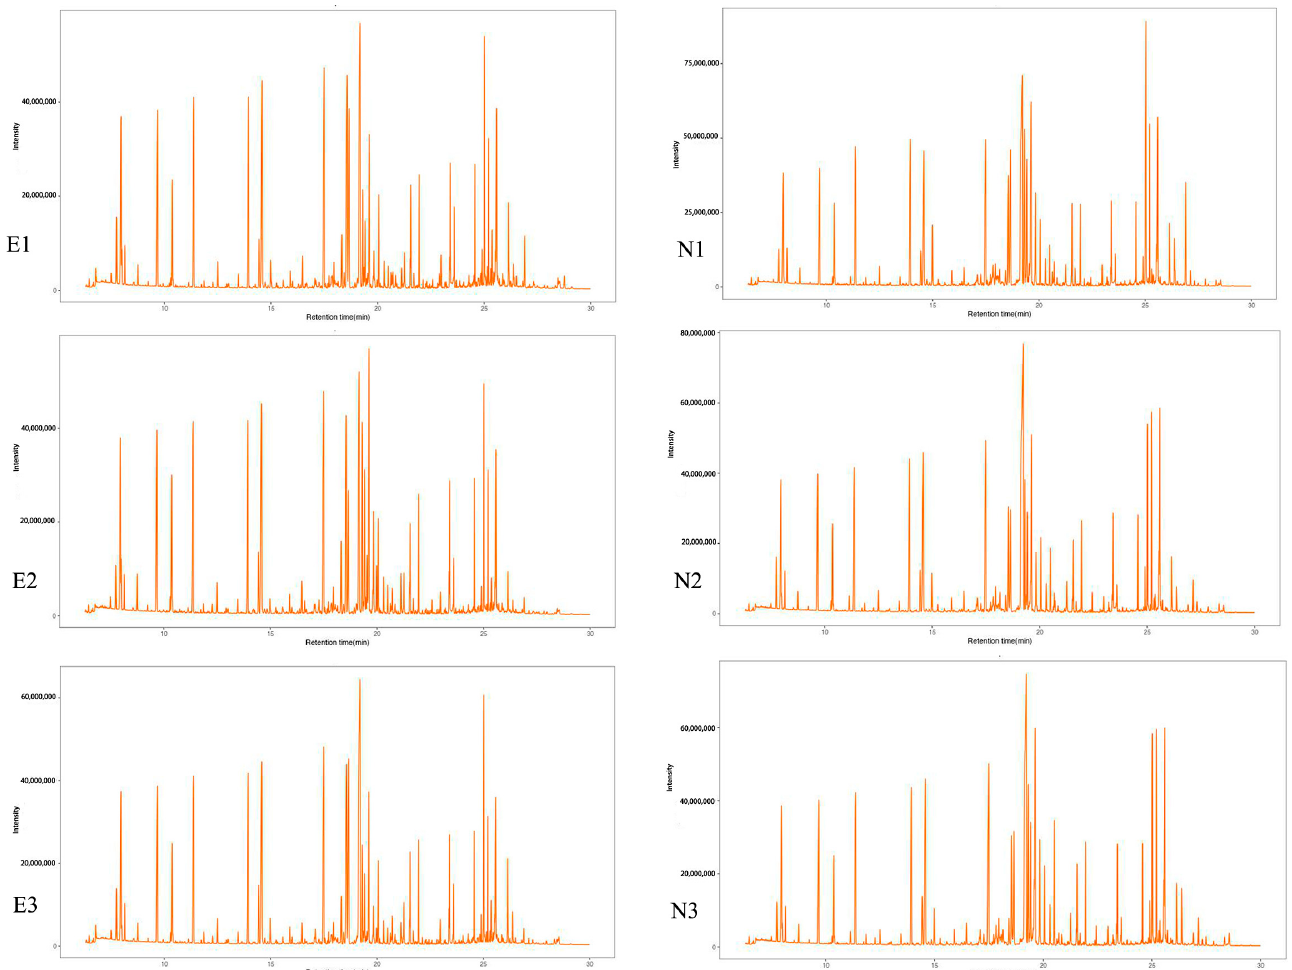
Figure 2. Total ion current (TIC) chromatogram of damaged leaves attacked by E. onukii of C. tetracocca and healthy leaves based on GC-MS. E1, E2 and E3 represents the groups of the leafhopper feeding, N1, N2 and N3 represents the groups of leafhopper not feeding.